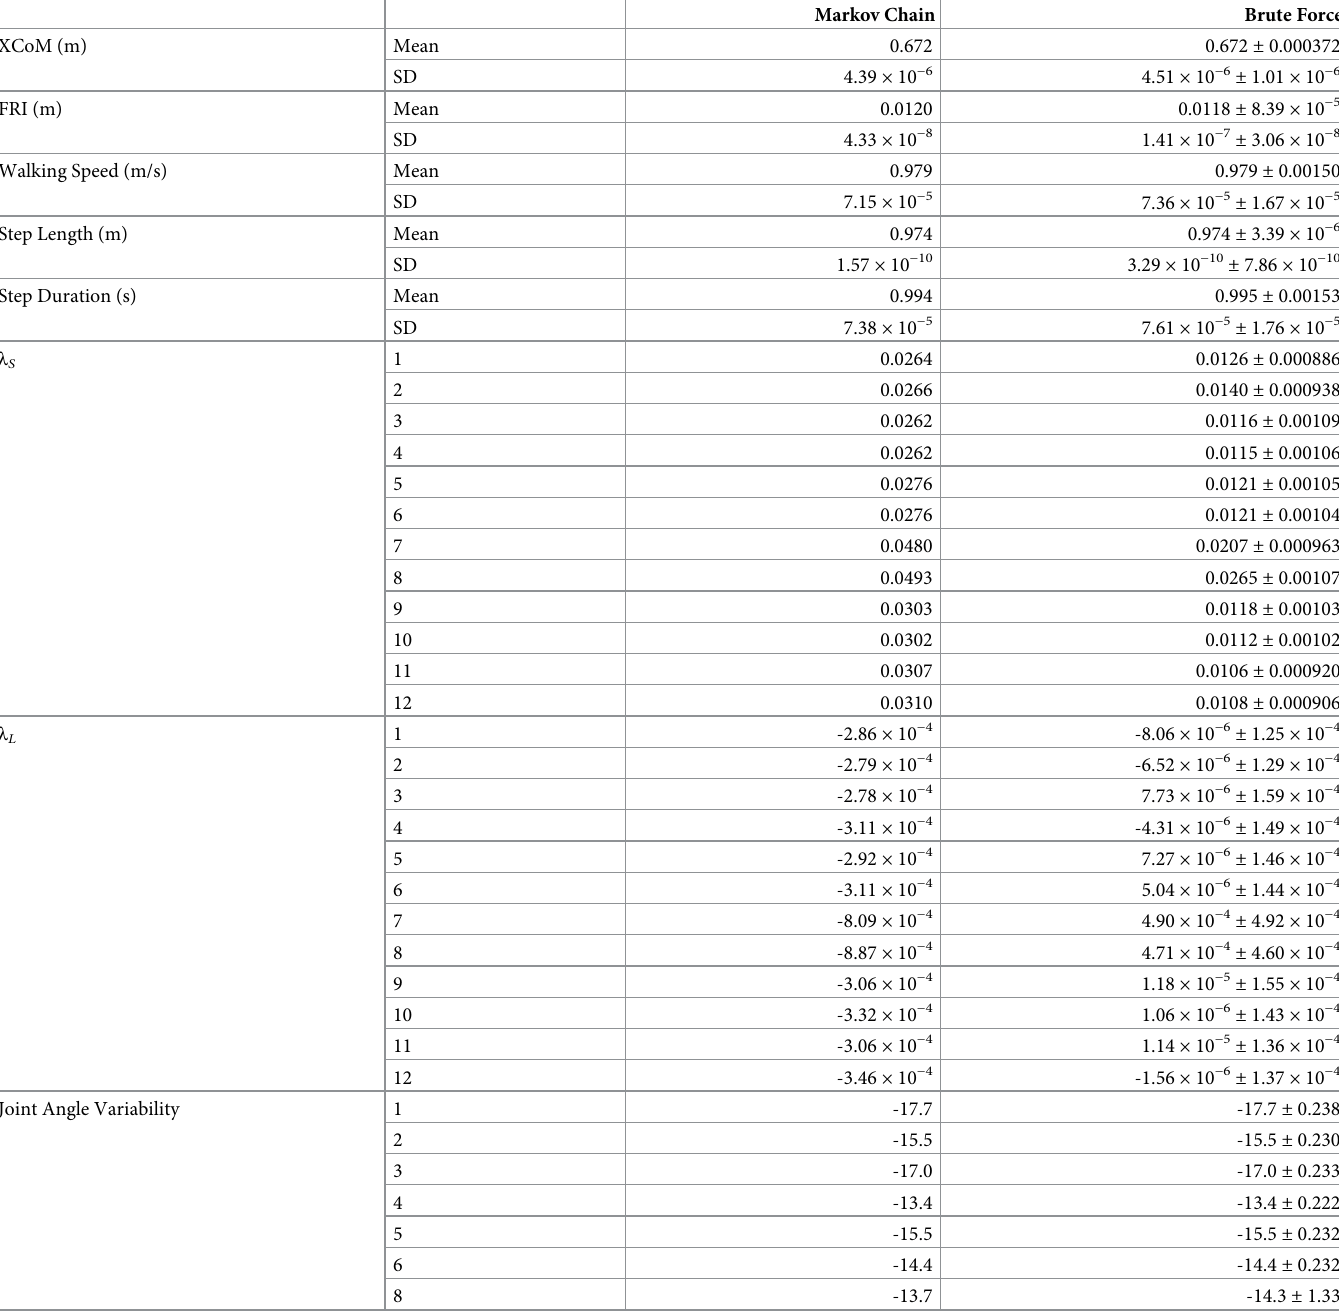
Table 2. Un-normalized fall risk metrics for one representative case (nominal speed � 1.0 m/s with a finite-time double support and perturbations at the beginning of double support). The values from the Markov chain calculations and the mean ± standard deviation from the 50 step brute force simulations are given. Similar to the comparison with normalized values, most metrics matched between the two methods. The main exceptions were the Lyapunov exponents, with the brute force values con- sistently much smaller than the Markov chain